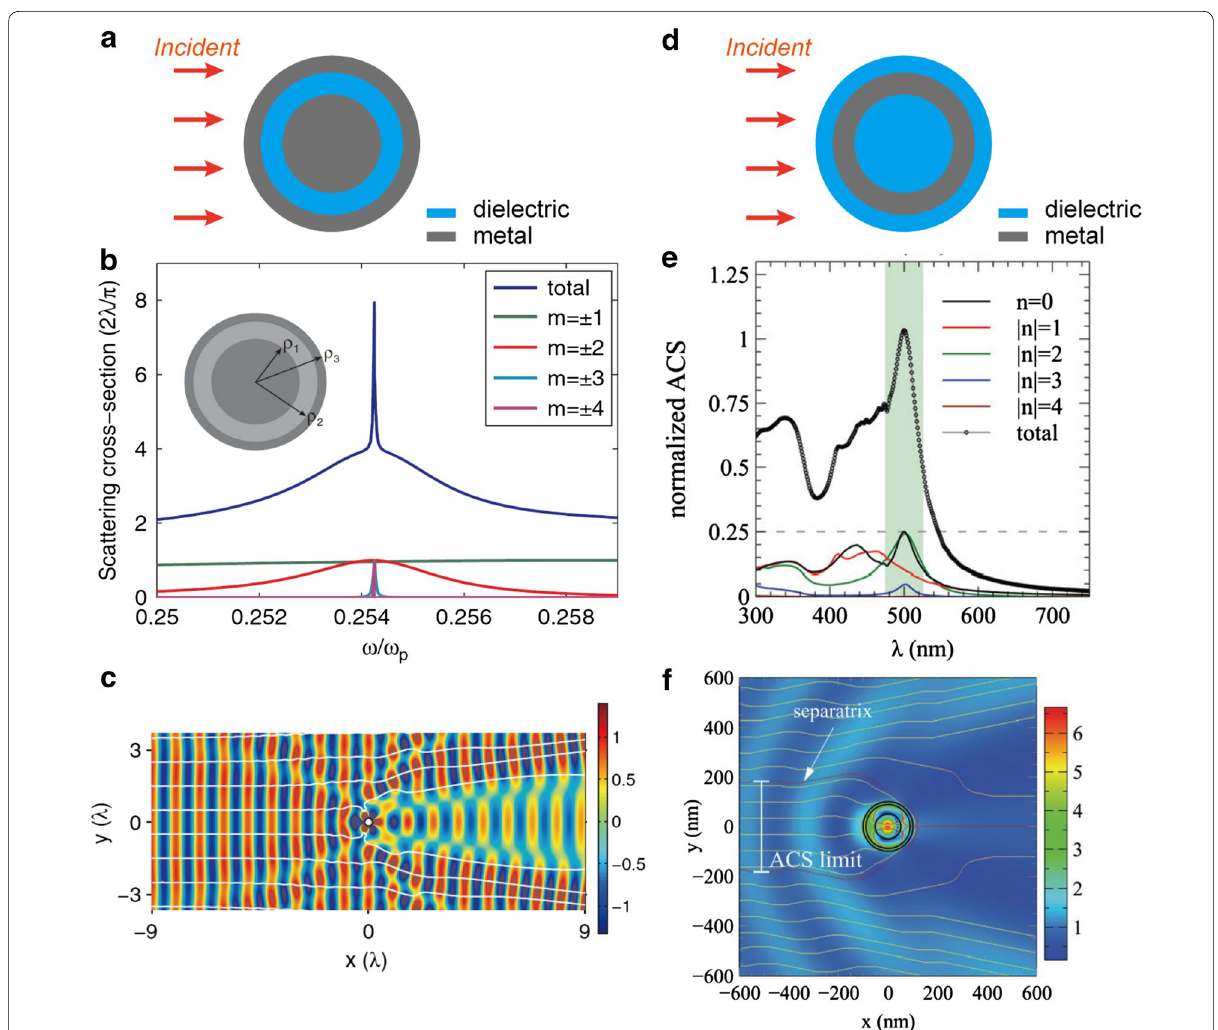
Fig. 4 Super‑scattering and super‑absorption of multilayered coaxial metal/dielectric nanostructures. a Schematic illustration of a core/multi‑shell NW structure for super‑scattering. The NW is composed of a metal core and a layered dielectric/metal multi‑shell. b Scattering cross‑section spectra of the NW in the lossless case. Total scattering and scattering contributions of individual angular modes are shown. The permittivity of the dielectric layer was set to 12.96. The permittivity of the metal layer was described by the Drude model with ε (lossless case). The inset shows the geometrical parameters of the NW: ρ 1 is the speed of light in vacuum. c Near‑field distribution and Poynting vector lines of the super‑scattering NW at a frequency of 0.2542 ω p . d Sche‑ matic illustration of a core/multi‑shell NW for super‑absorption. The NW is composed of a dielectric core and a layered metal/dielectric multi‑shell structure. e Normalized absorption cross‑section spectra of the NW. Total absorption and absorption contributions of individual angular modes are shown. Si and Ag were used as dielectric and metallic materials, respectively. The geometrical parameters, ρ 1 , ρ 2 and ρ 3 for the NW were set to 51, 92 and 100 nm, respectively. f Near‑field distribution and Poynting vector lines of the super‑absorption NW at a wavelength of ~ 500 nm ( b , c are adapted from [33], and e , f are adapted from